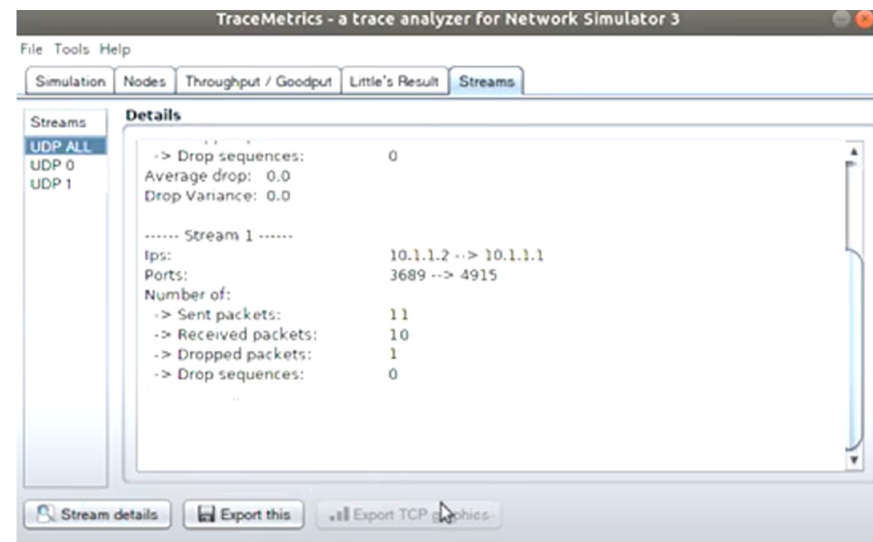
Figure A3. NS ‐ 3.35: Data Transmission. Figure A3. NS-3.35: Data